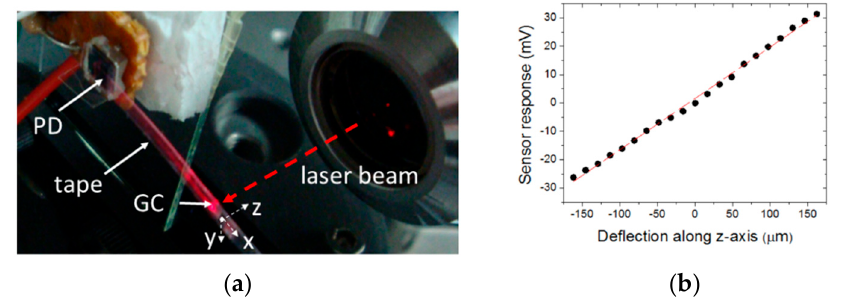
Figure 6. ( a ) Photograph of the fabricated tape waveguide cantilever with an integrated grating coupler (GC) [28]. The GC-free waveguide tip end is anchored onto a photodiode (PD), and the tip containing the embedded GC deflects along the z-axis. ( b ) Experimental cantilever response as a function of the tip-grating deflection [28] and a linear fit of the measured data (red line).